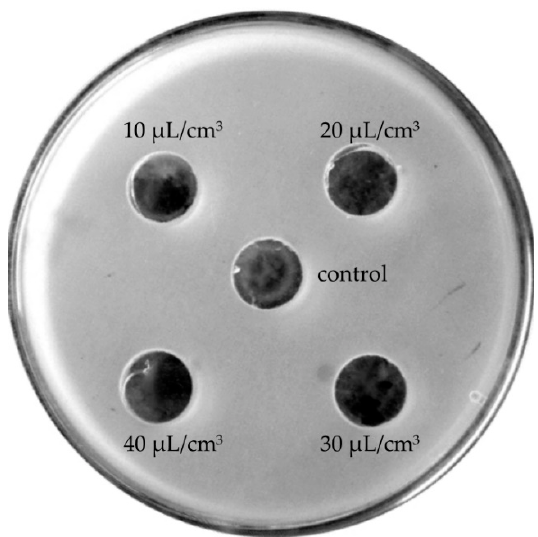
Figure 4. Neutral effects of lavender oils on the growth of the bacterial species Enterococcus faecium .